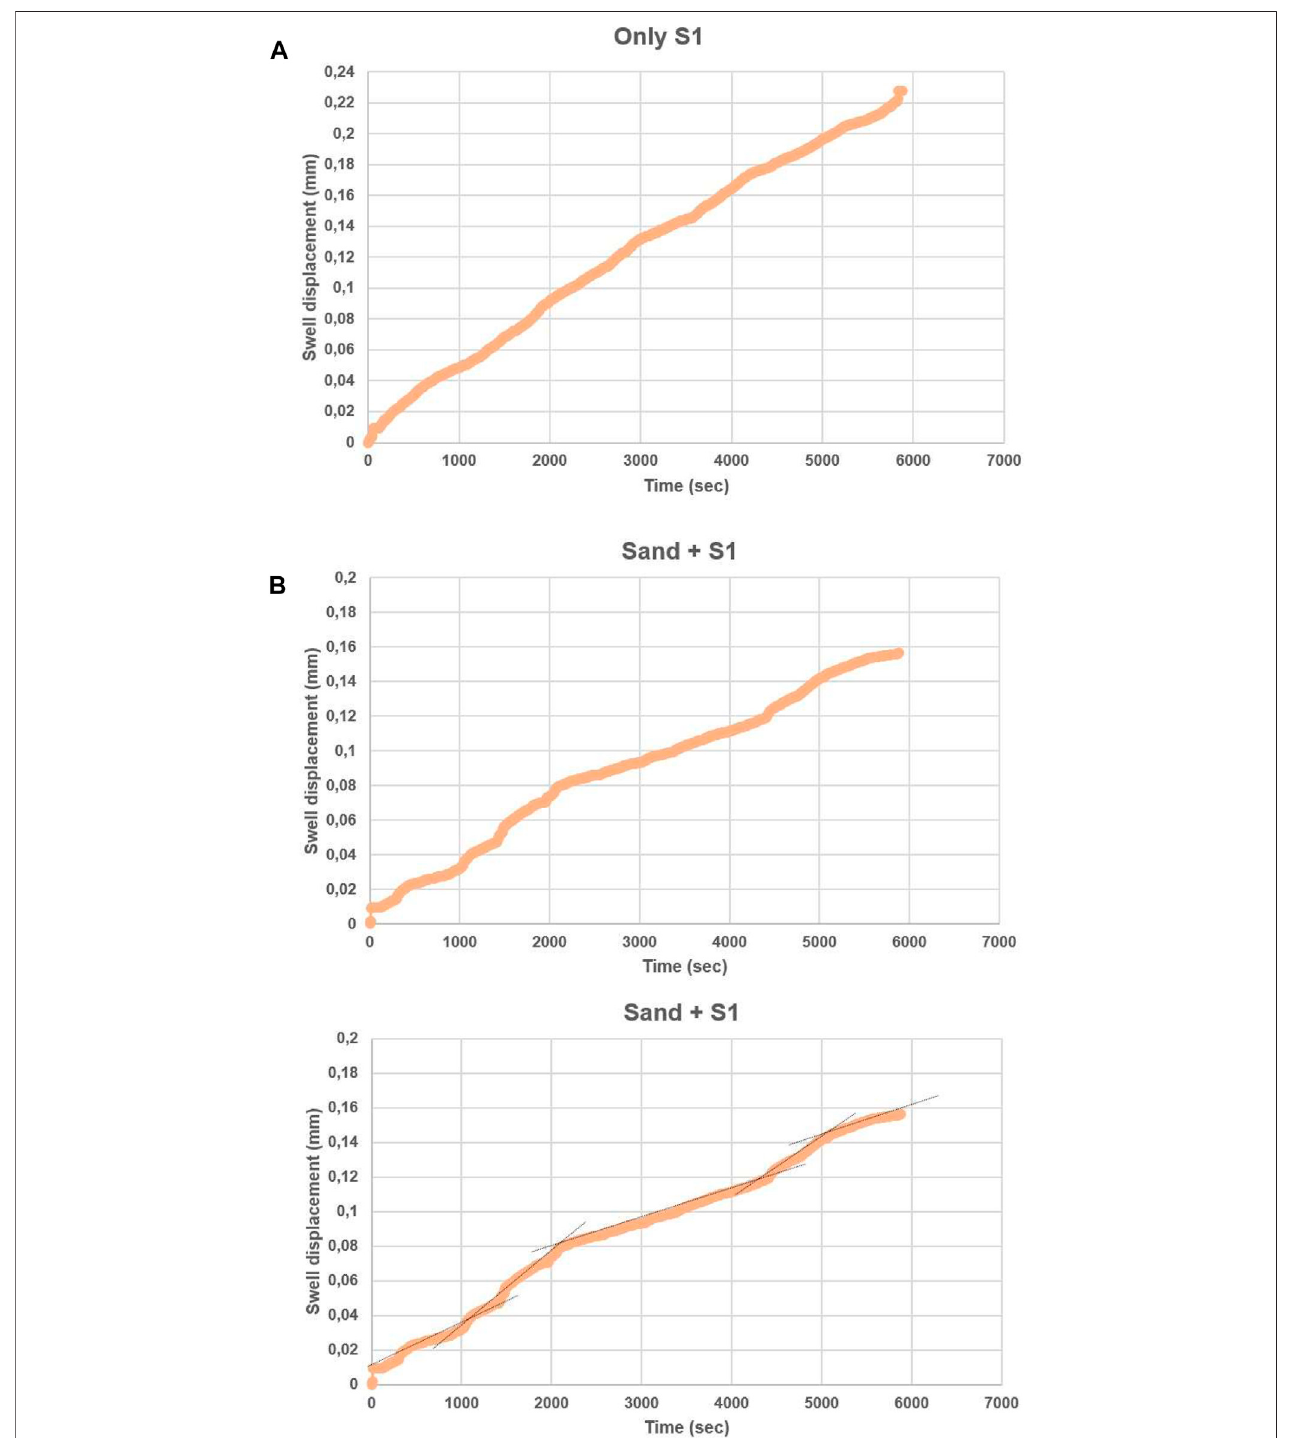
FIGURE 14 | (A) Free swell — Time curve of case 1 (only expansive clay) under 0.25 kPa. (B) Free swell — Time curve of case 2 (47% Sand +47% S1) under 0.25 kPa.